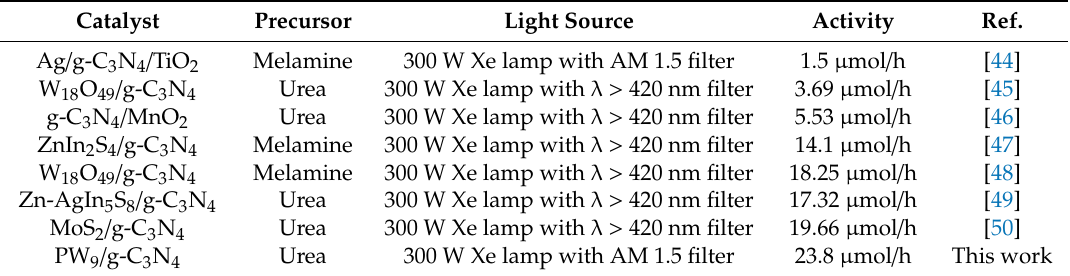
Table 1. Photocatalytic activity of reported g-C 3 N 4 -based photocatalysts for H 2